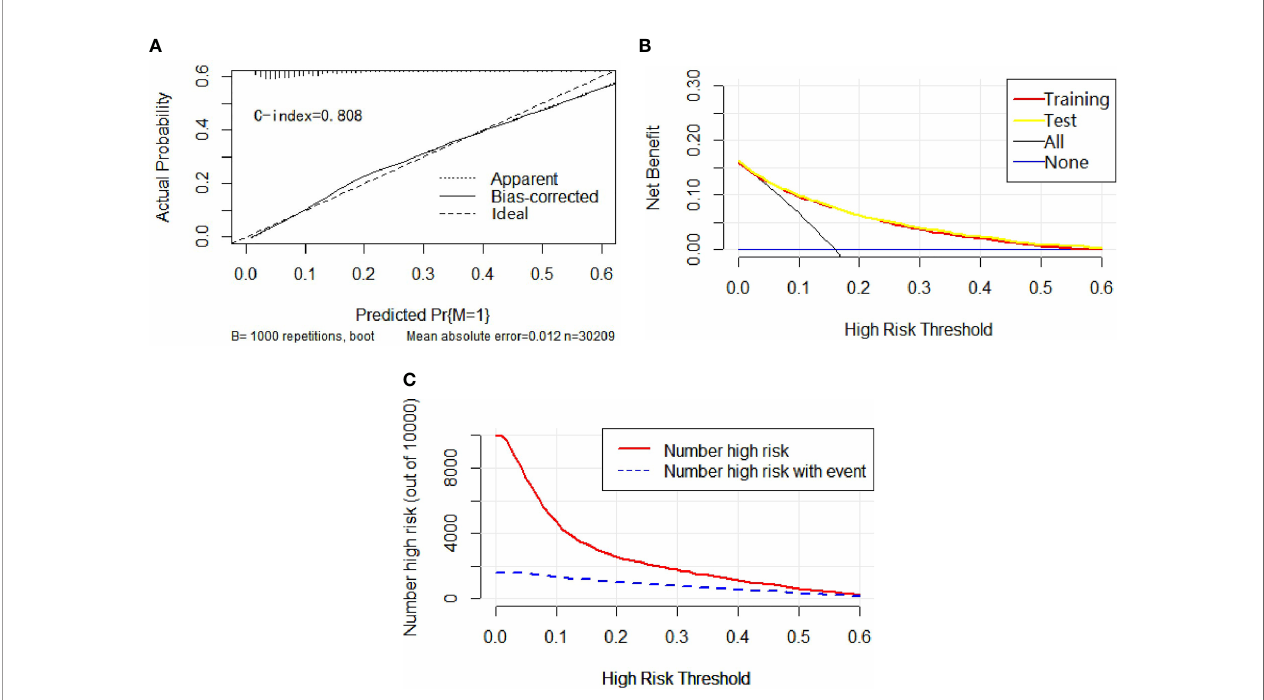
FIGURE 6 | In calibration curve (A) , the x-axis represents the predicted probability of DM, the y-axis stands for the actual probability of DM, and the ideal line is the diagonal of the graph, indicating that the predicted probability is utterly equal to the true likelihood, which is the ideal condition of the prediction model. The apparent line represents the theoretical prediction ability, and the bias-corrected marks the prediction ability of the corrected model. The fi gure reveals that the above three lines are very close, and c-index = 0.808, suggesting that the prediction model is very accurate. In the decision curve (B) , the x-axis represents the threshold probability, the y-axis refers to the net income, the horizontal blue line is an extreme case that no patients suffer from DM, and the black line represents another extreme case that all patients have DM. The red line and the yellow line are predicted by the training group and the test group, respectively. The two lines basically coincide, indicating that the prediction ability of the model is stable and reliable. In the clinical impact curve (C) , the x-axis represents the different thresholds of DM, and the y-axis marks the number of people. The red line indicates the number of high-risk patients under different thresholds, and the blue line indicates the actual number of DM in high-risk patients under different